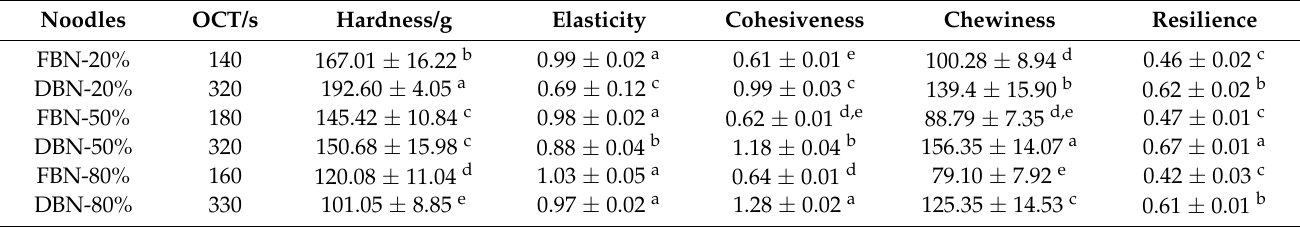
Table 1. Optimum cooking time and textural properties of cooked FBN and DBN.